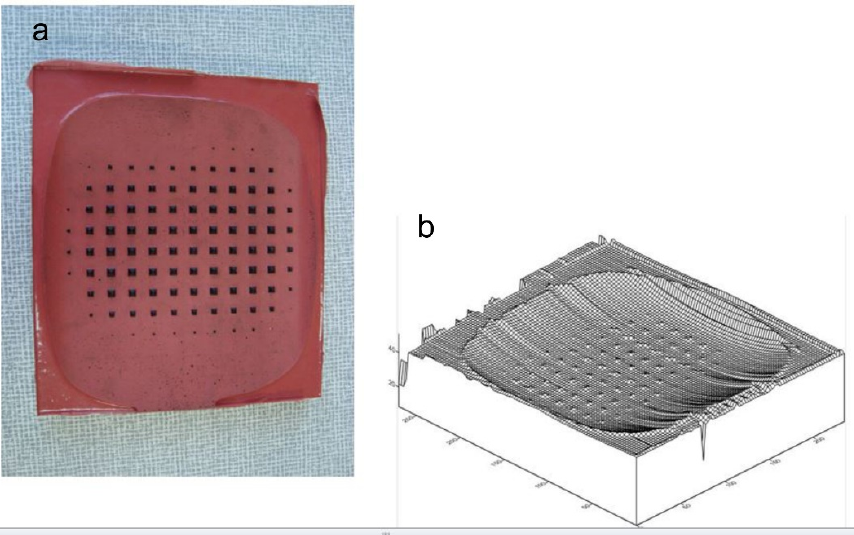
Figure 7. Contact deformations obtained on experimental pavement composed with equally spaced pyramids: ( a ) rubber casting; ( b ) digital model.